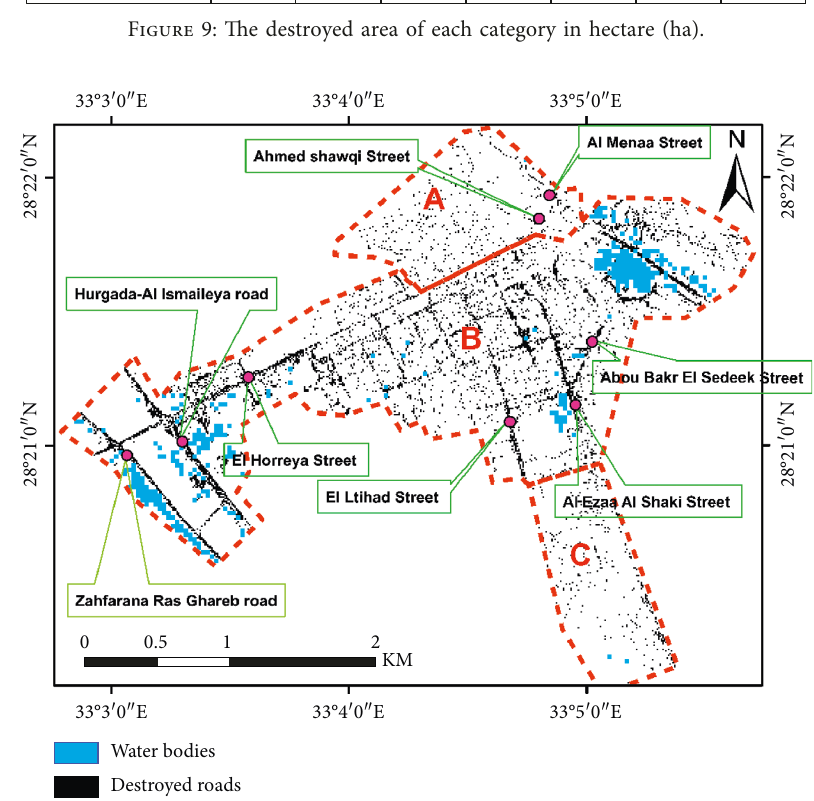
Figure 10: The damage of the main and branch road network, also the location of the ephemeral water bodies inside the city. Table 3: The pairwise comparison matrix of authors’